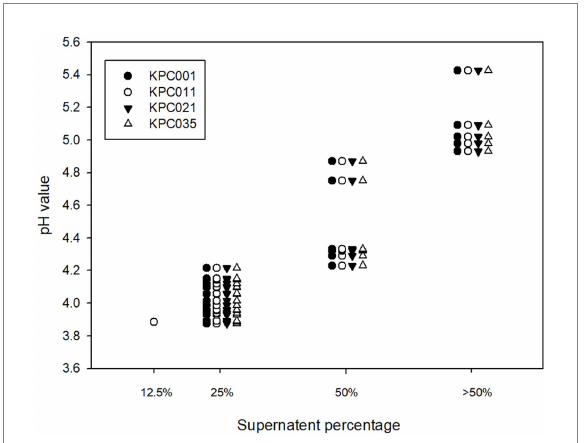
FIGURE 2 Correlation of the pH of cell-free supernatants and MIP against carbapenemase-producing Klebsiella pneumoniae